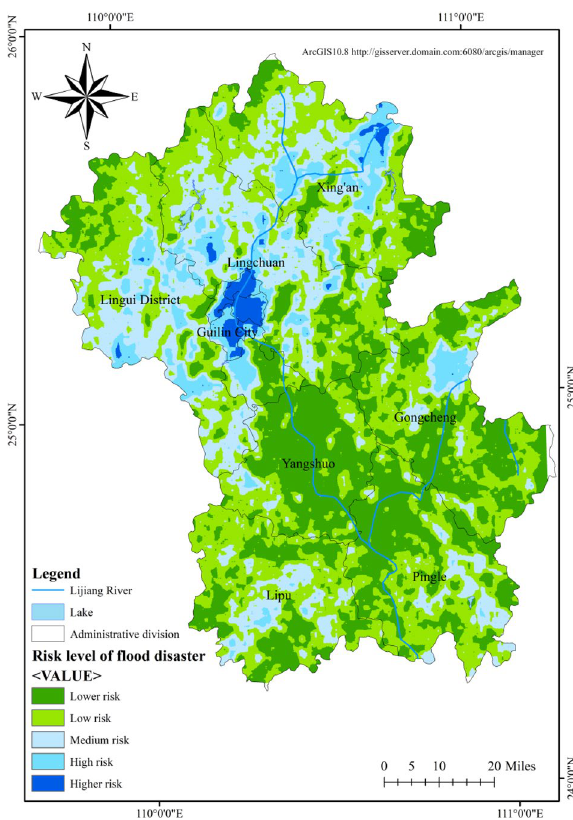
Figure 7. Risk level of flood disaster in Lijiang River Basin.